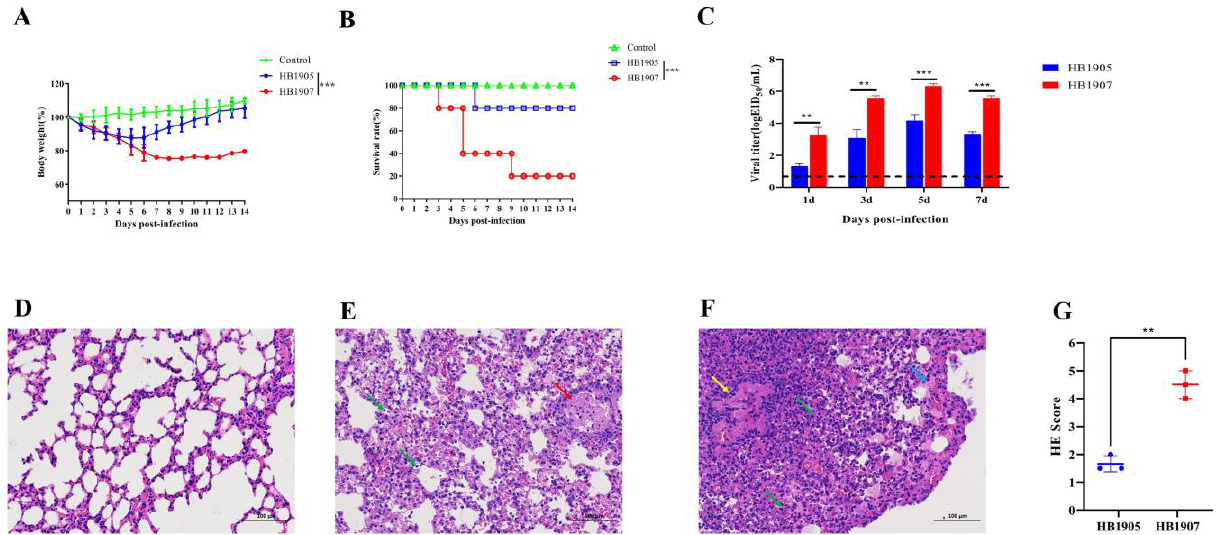
Figure 5. Pathogenicity in HB1905- and HB1907-infected mice. ( A ) Daily weight monitoring was performed for each group for 14 days. ( B ) The mortality rate of each group was recorded for 14 consecutive days. ( C ) Replication of HB1905 and HB1907 viruses in mouse lung. The dashed line represents the lower limit of virus detection. ( D ) Lung pathological sections of mice in the control group at 5 dpi. ( E ) Lung pathological sections of mice in the HB1905 group at 5 dpi. ( F ) Lung patho- logical sections of mice in the HB1907 group at 5 dpi. ( G ) Pathology scores in the lungs of infected BALB/c mice. Images were acquired using a ×20 magnification objective. Alveolar wall thickening (arrow green), lymphocyte infiltration (arrow red), epithelial cell necrosis (arrow yellow), inflam- matory cell infiltration; (arrow blue), acidophilic protein-like exudation. Three independent exper- iments were performed in each group (** p < 0.01, *** p < 0.001).